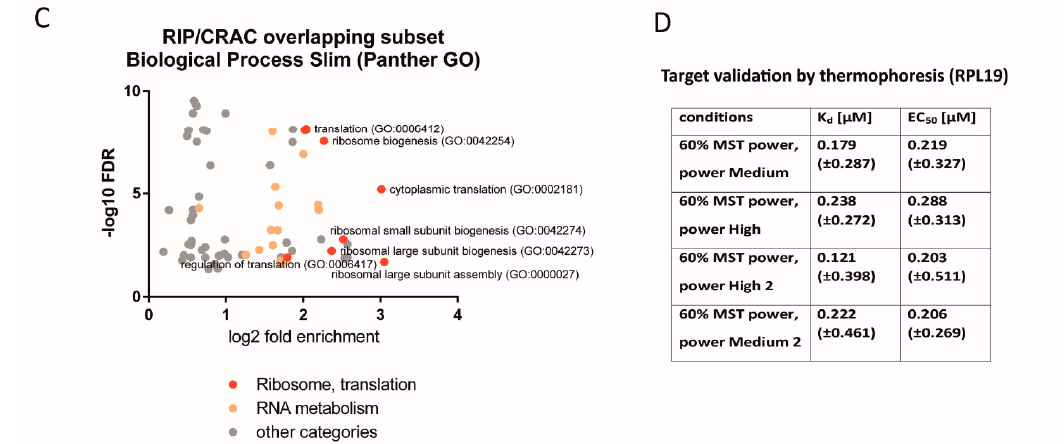
Figure 4. Characterization of the overlapping CRAC–RIP subset of HAX1 mRNA targets. ( A ) Overlapping targets in RIP and CRAC_C (629 mRNAs) represent, respectively, 13.7% and 38.5% of the overall results. Hypergeometric test for these overlap gives p -values of 9.8e–42 (total gene set: 15220). ( B ) Functional annotation enrichment of the RIP/CRAC overlap of HAX1 target genes